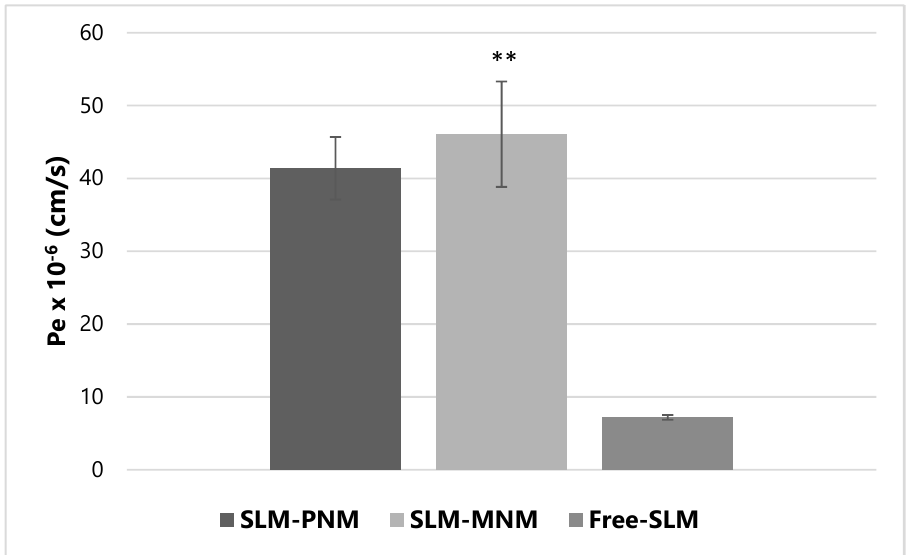
Figure 4. Effective permeability (P e ) of free-silymarin (Free-SLM), silymarin-loaded polymeric nanomicelles (SLM-PNM) and silymarin-loaded mixed nanomicelles (SLM-MNM). Data are expressed as mean ± SD, n = 3. ** p < 0.01 vs. free silymarin, by Kruskal-Wallis test and Dunn’s multiple comparisons test.